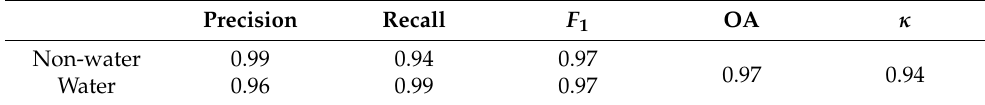
Table 4. Accuracy of water extraction from S-1 imagery in the GEE.